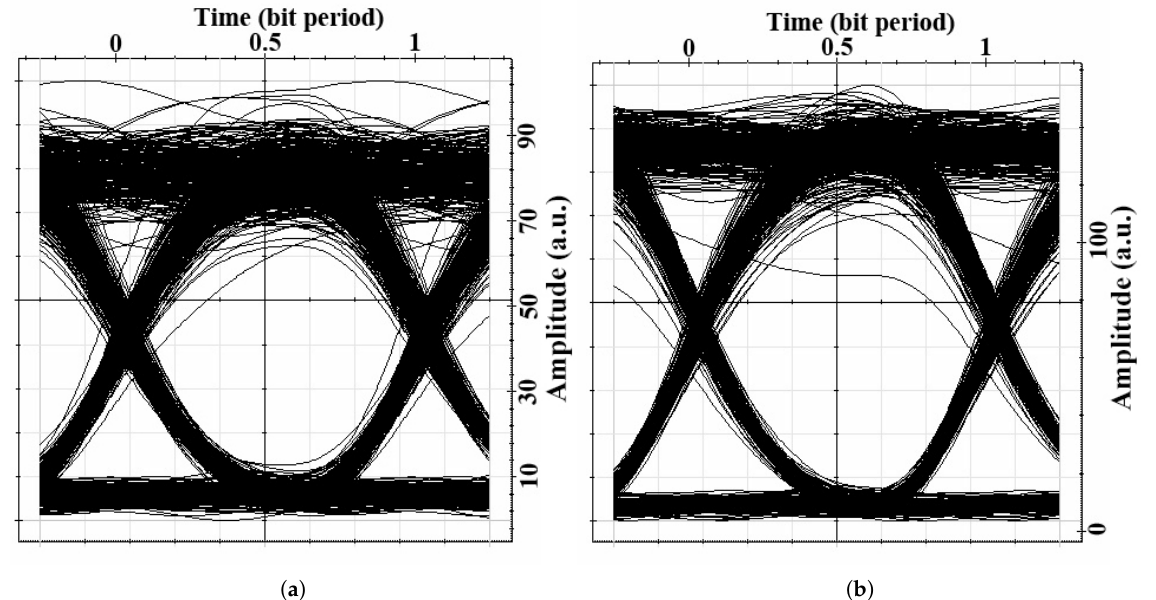
Figure 6. Eye diagram of signals related to ( a ) data service and ( b ) video surveillance data after 3.2 km propagation in